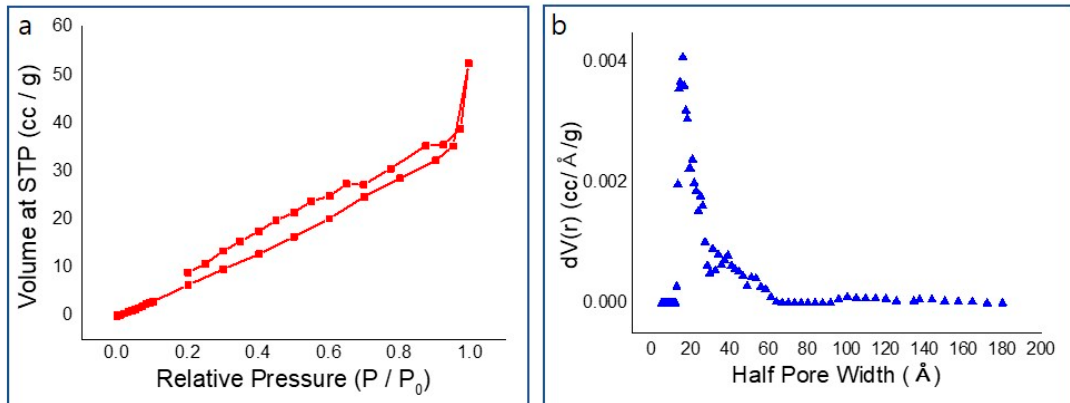
Figure 8. ( a ) N 2 adsorption / desorption isotherms; ( b ) Barrett–Joyner–Halenda pore size distribution plot of beech wood.